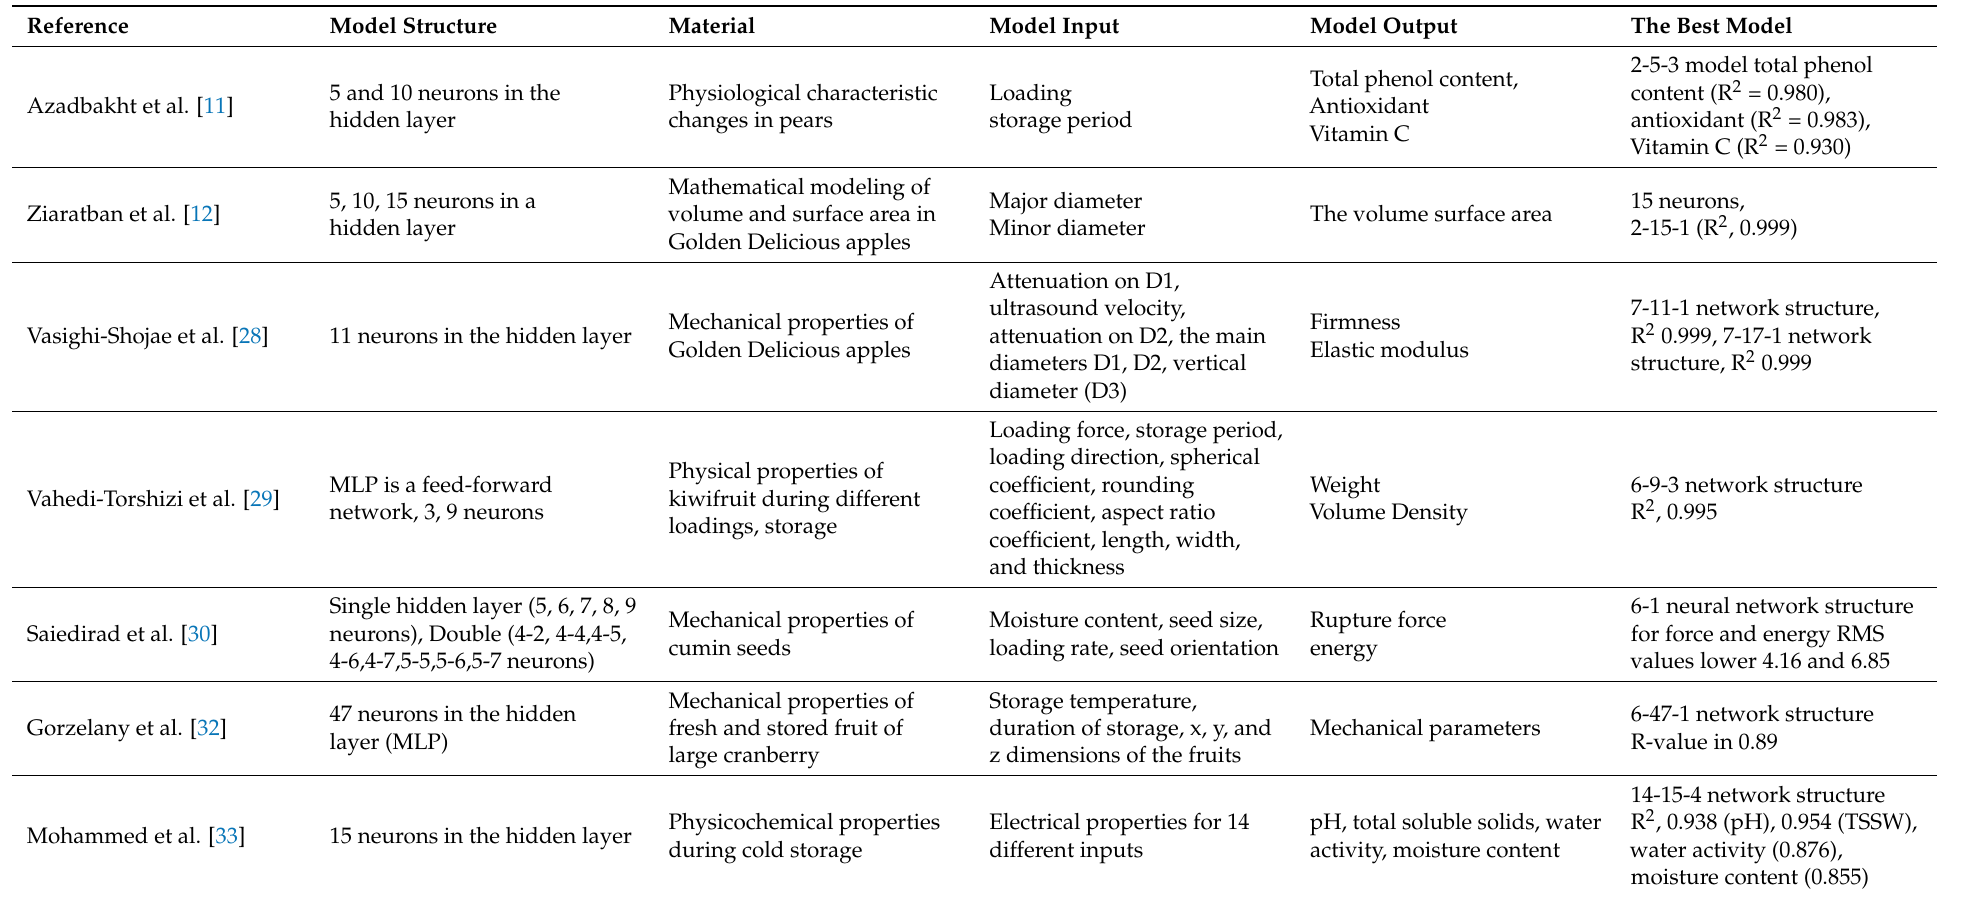
Table 5. Studies of ANN for different